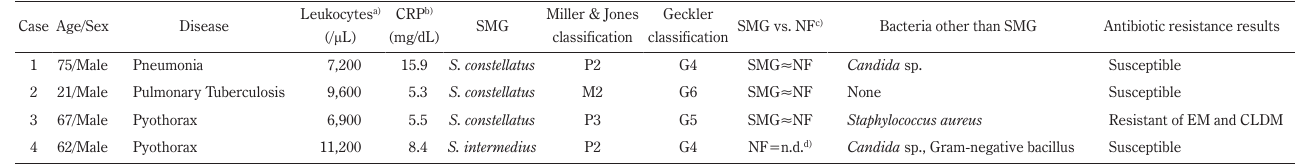
Table 2 Cases in which the volume of SMG bacteria was equal to the volume of NF detected or in which no NF was detected